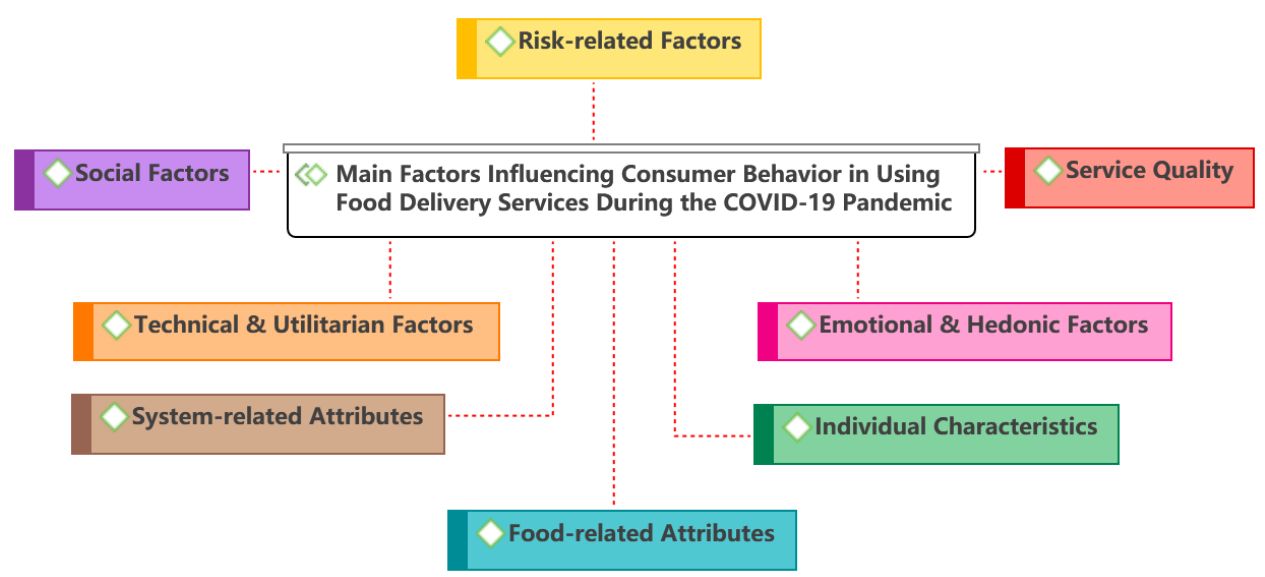
Figure 4. Main factors influencing consumer behavior.